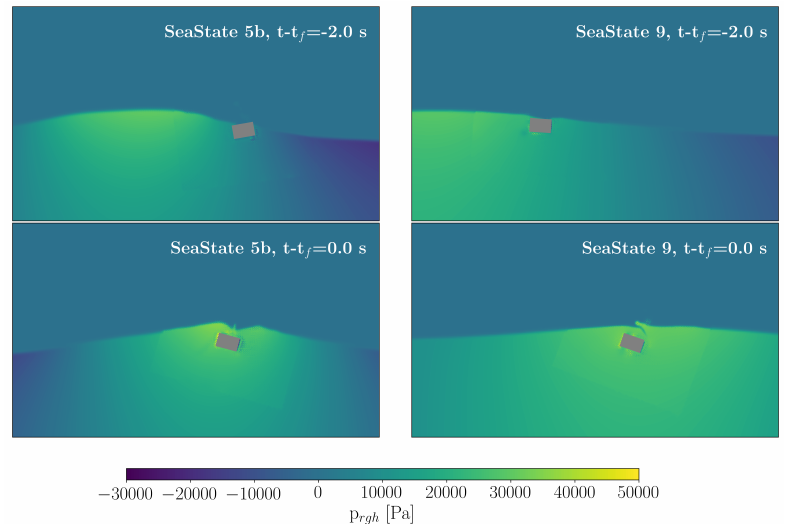
Figure 21. Wave–structure interaction at the sea states 5b (left column) and 9 (right column) as colored by the dynamic pressure, p _ rgh . The pictures show the motion a few seconds before the t f = focusing time ( t 2 s , on the top) and at the focusing time ( t − −